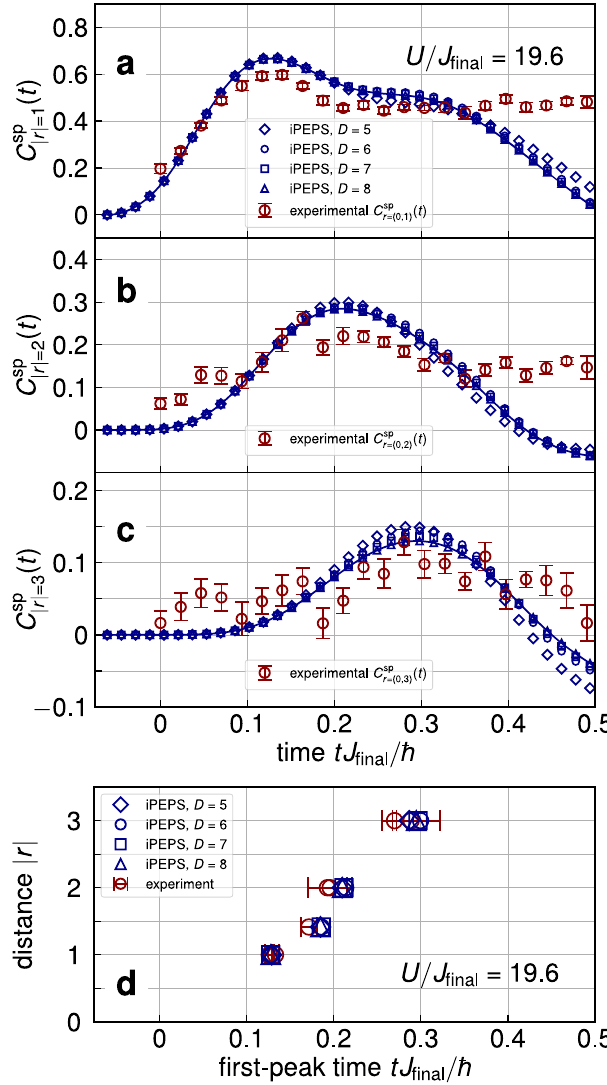
Fig. 3 Single-particle correlation functions C sp r ð t Þ in the case of a fi nite- time quench. Comparison is made between the in fi nite projected entangled pair state algorithm (iPEPS, blue lines with symbols) and the experiment (red circles with error bars). The unit of time is taken as the inverse of the strength of the hopping J fi nal after the quench. U is the strength of the interaction. D is the bond dimension. The correlations at distances ( a ) ∣ r ∣ = 1, ( b ) ∣ r ∣ = 2, and ( c ) ∣ r ∣ = 3 are shown. The error bars represent the standard error of fi ve independent measurements 3 . d Comparison of the fi rst-peak time between the iPEPS and experimental results. The error bars represent the fi tting errors 3 . The iPEPS and experimental results agree within the experimental errors in all